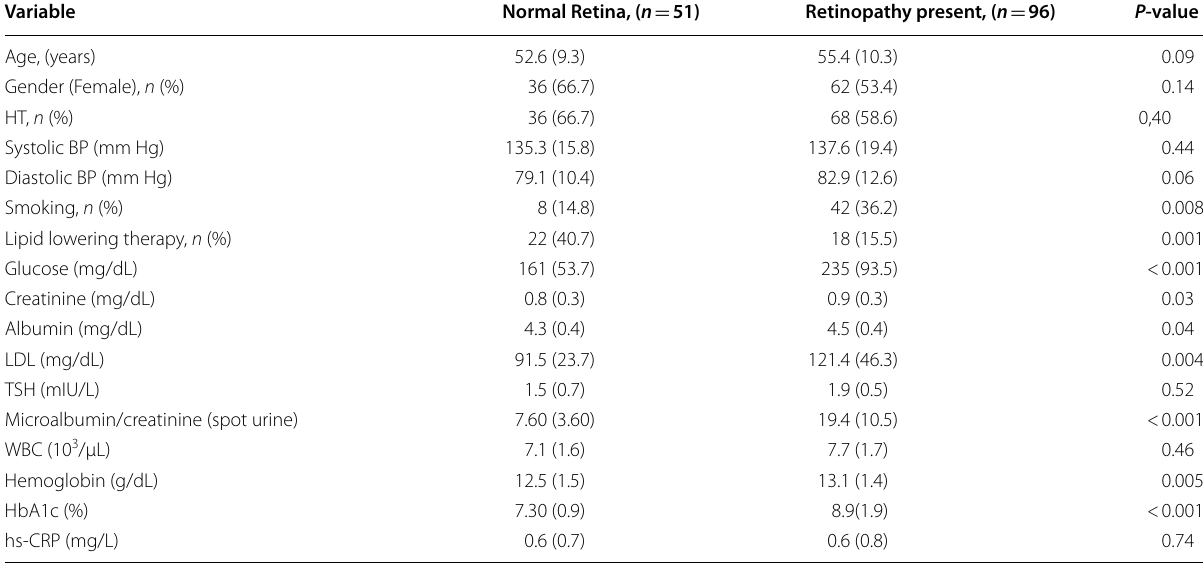
Continuous variables are presented as mean and standard deviation (SD) BP, Blood pressure; LDL, low-density lipoprotein; TSH, Thyroid stimulating hormone; WBC, White blood cell; hs-CRP, High sensitive C-reactive